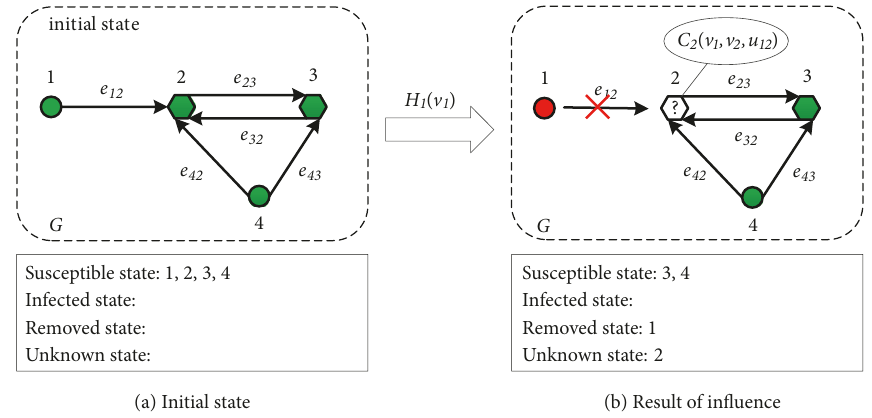
Figure 2: Influence of bankruptcy of nonlisted holder 1 on the